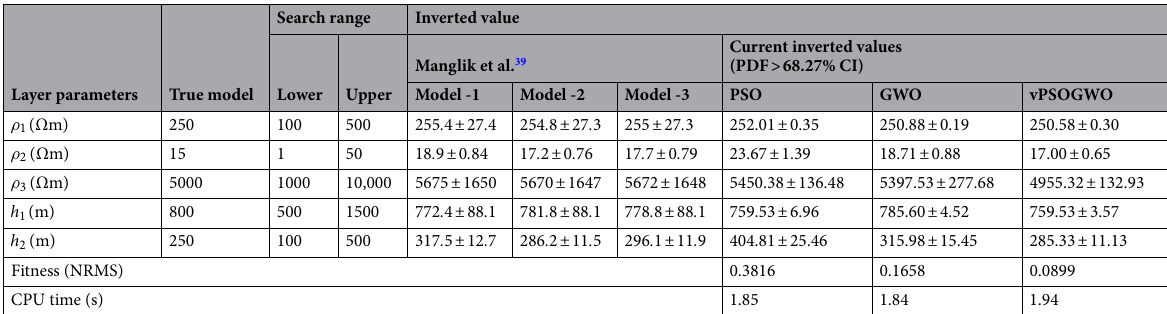
Table 5. Mean model with the level of uncertainty in the posterior utilizing individual inversion of MT synthetic data distorted with 10% noise from vPSOGWO compared with results inverted by Manglik et al. 39